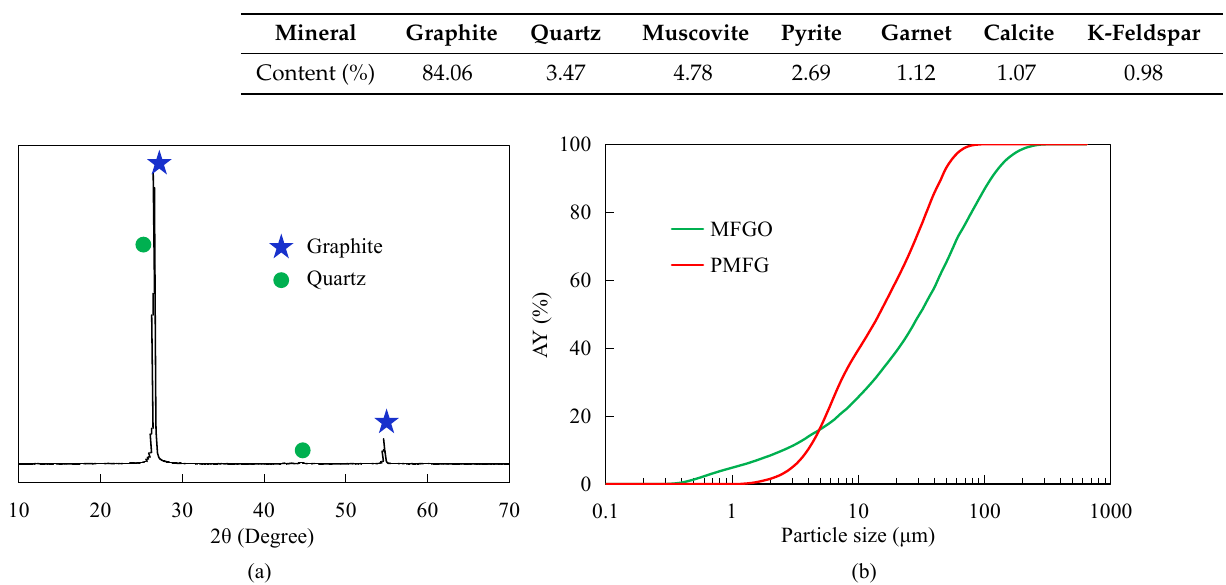
Figure 1. The XRD analysis results of PMFG ( a ) and particle size distribution results of MFGO and PMFG ( b ).